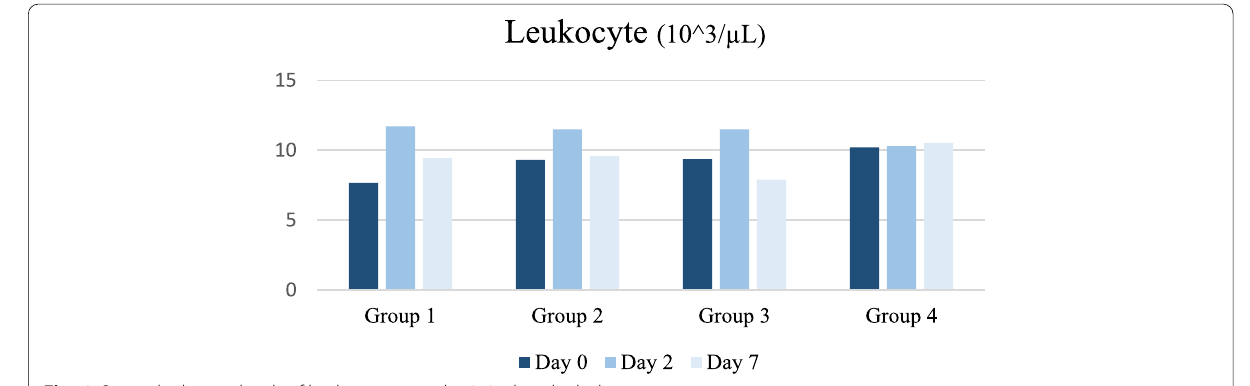
Fig. 6 Serum leukocyte levels of both groups on the 0, 2nd, and 7th days